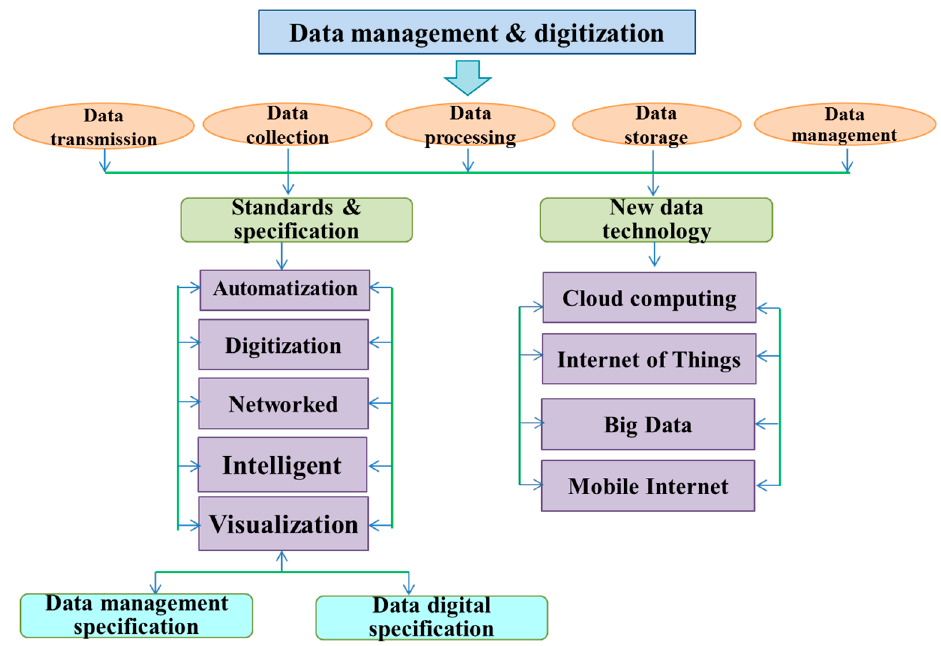
Figure 3. Management of the eco-stations’ data from the Chinese Forest Ecosystem Research Network (CFERN) used for the CFEIS.